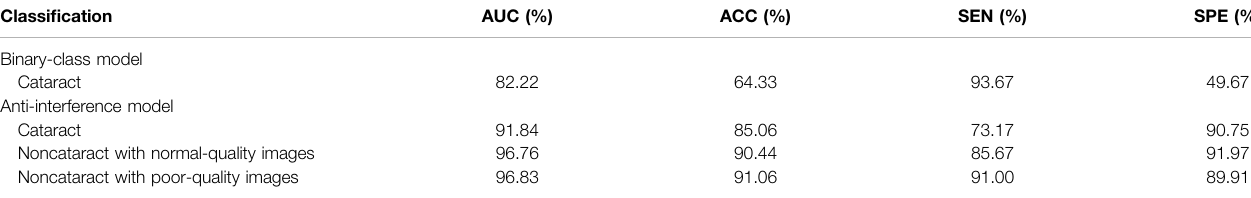
TABLE 2 | erformance of the two cataract arti fi cial intelligence diagnosis models in the internal validation dataset.